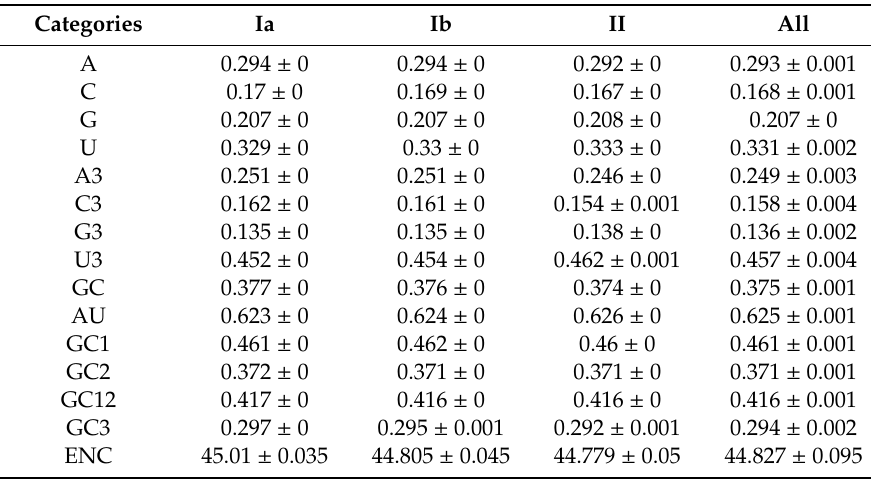
Table 1. Nucleotide contents and properties of the TGEV complete